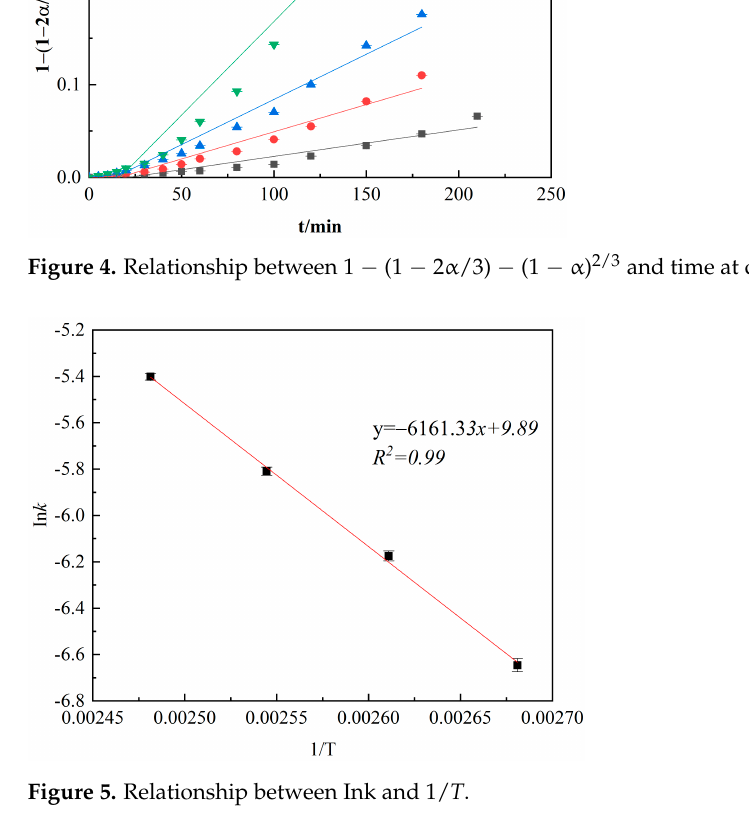
Figure 5. Relationship between Ink and 1/ T